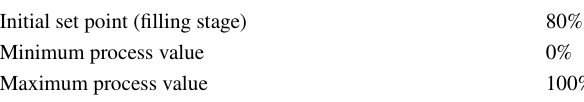
Table 6 Level flow controller set point for dynamic model